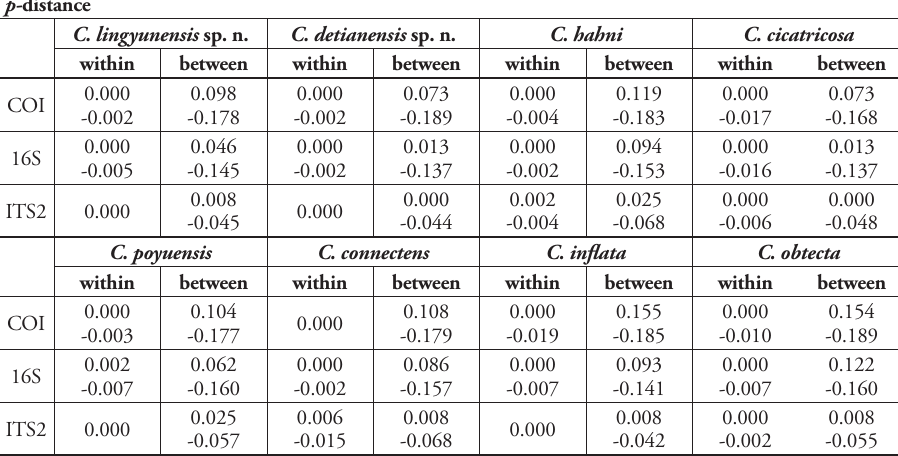
Table 3. Inter and intraspecific P -distances of sinistral Camaena species. p-